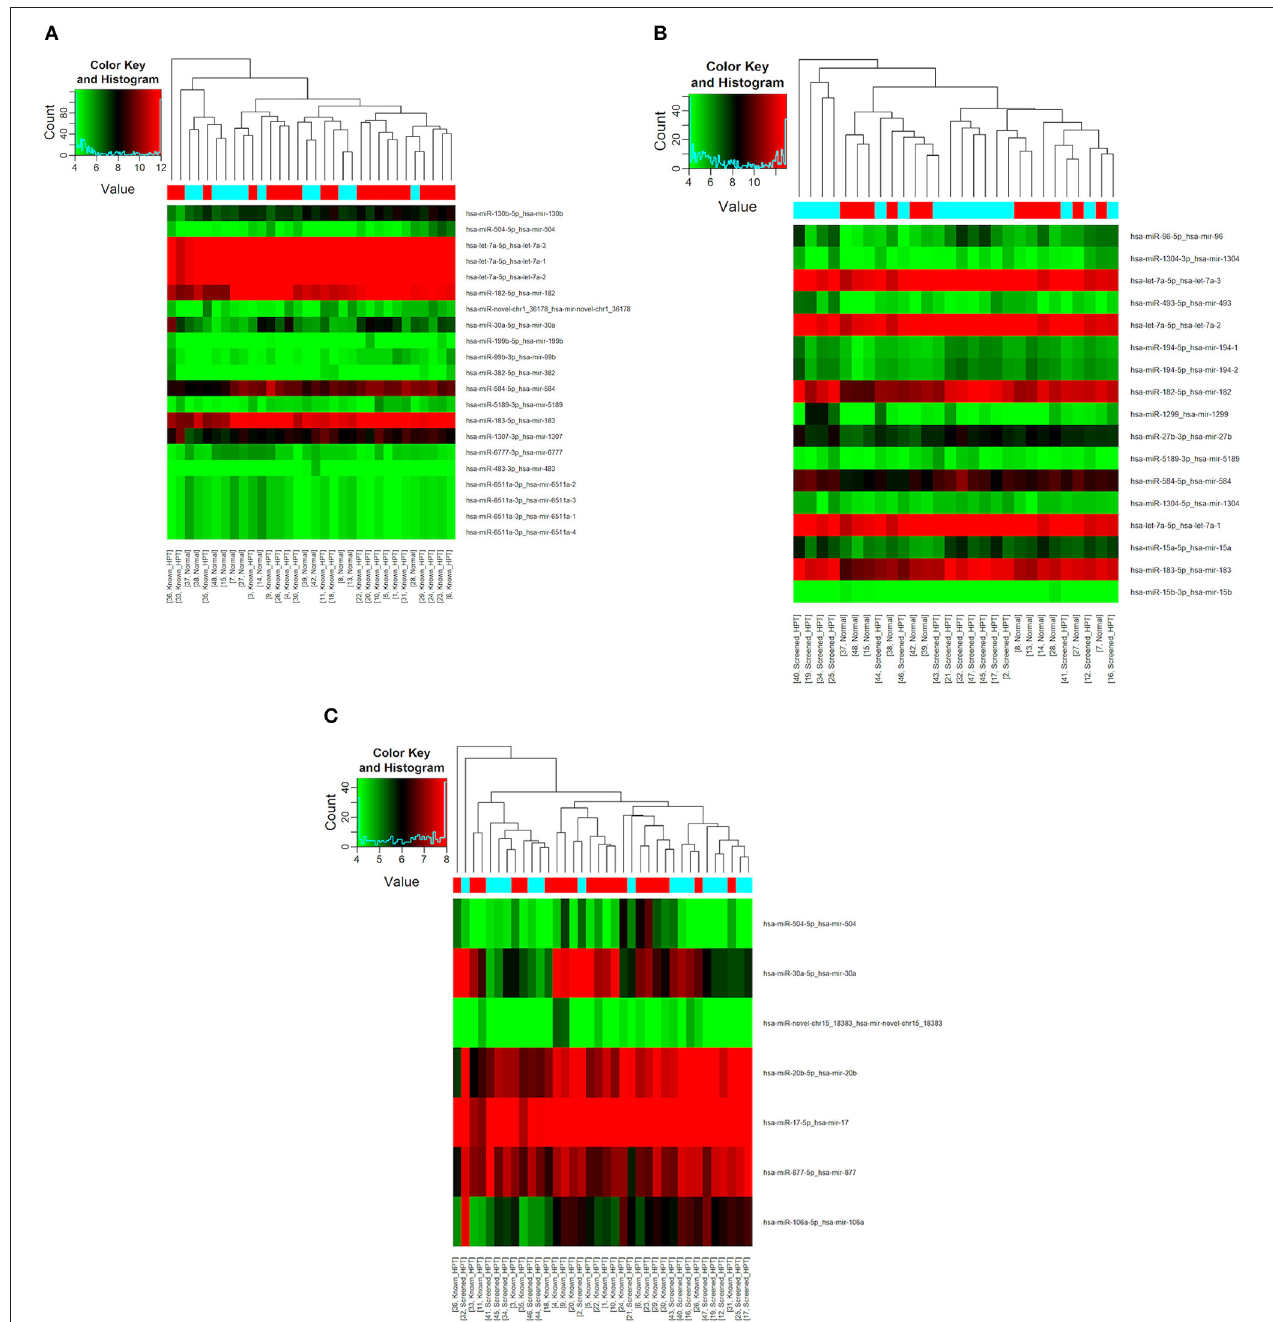
FIGURE 1 | Differential miRNA expression according to HPT status. The heatmap shows all differentially expressed miRNAs at adjusted p -value < 0.05. (A) Normotensive vs. known HPT; (B) Normotensive vs. screen-detected HPT; (C) Known HPT vs. screen-detected HPT.